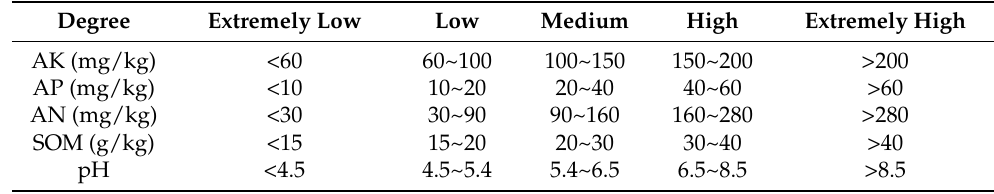
Table 2. Soil quality grading standards for orange groves